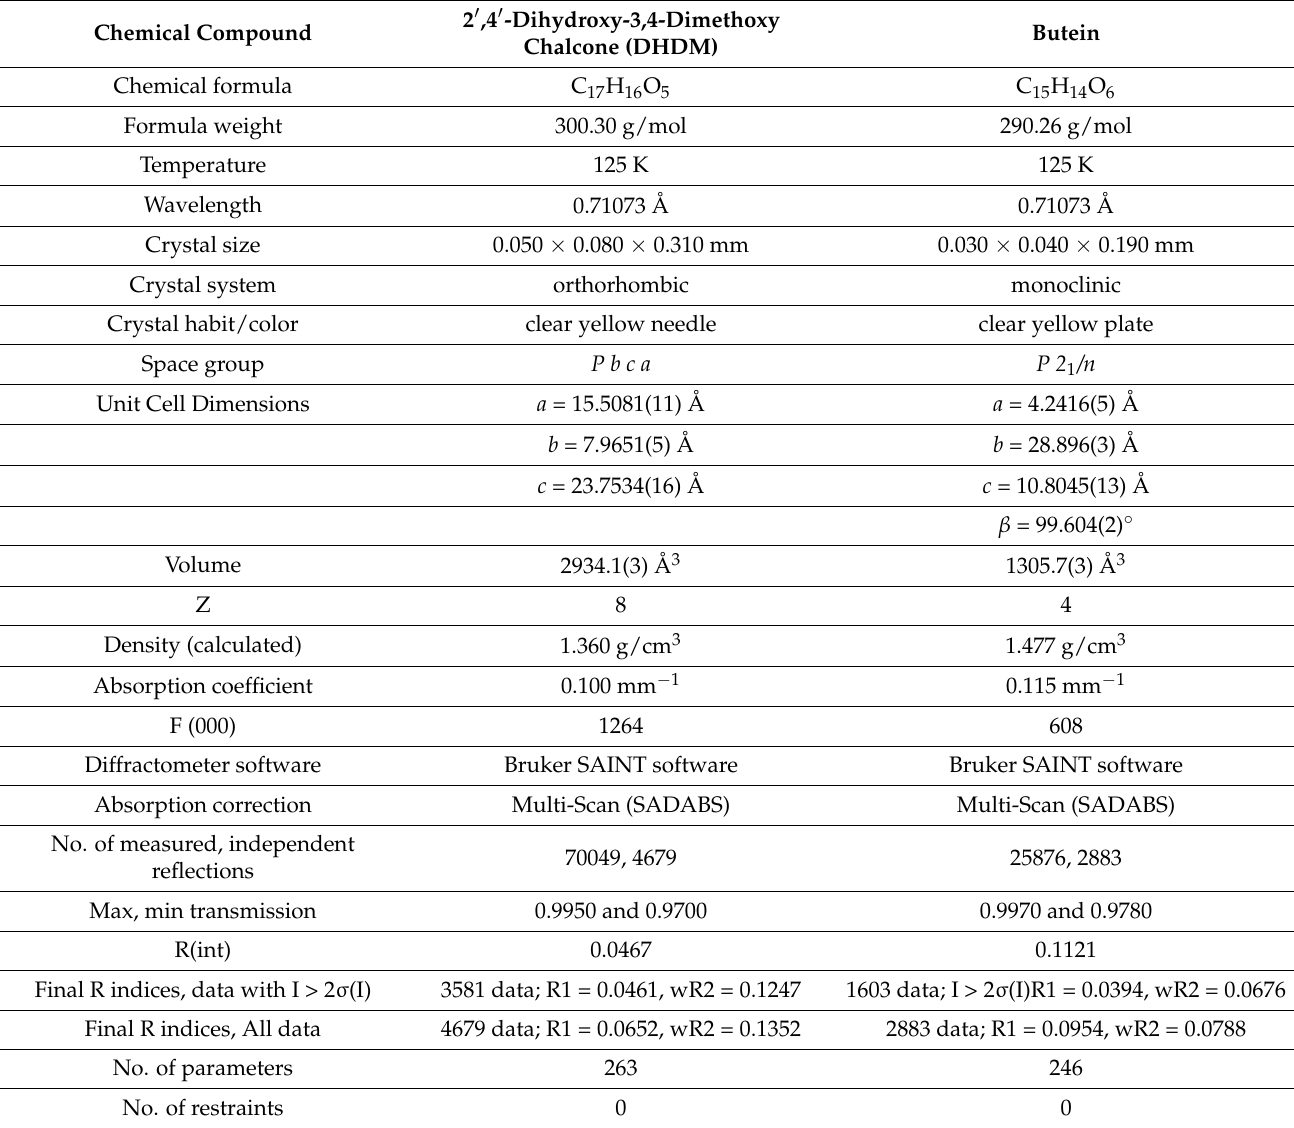
Table 1. Crystal Data of 2 (cid:48) ,4 (cid:48) -dihydroxy-3,4-dimethoxy chalcone, (DHDM) and